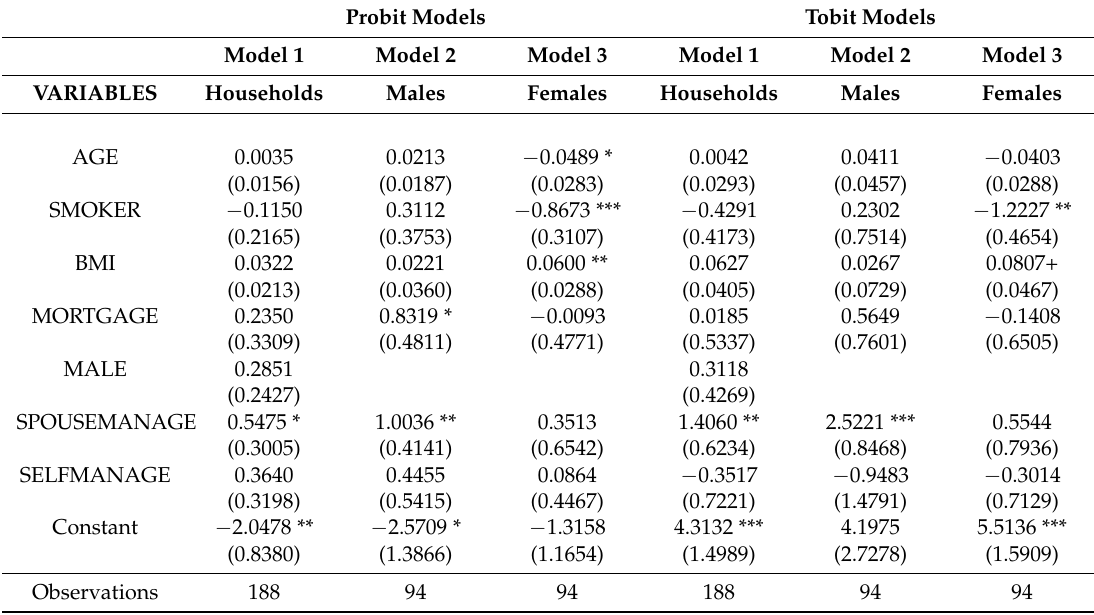
Table 9. Probit and tobit results (transferring $10 to